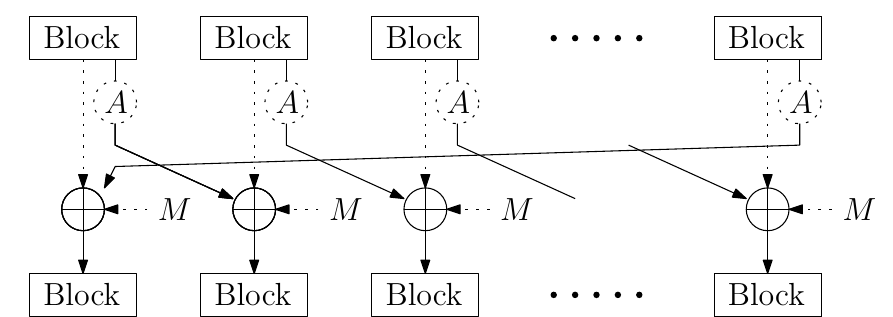
Figure 4: The general construction considered of the round function in [JN16]. Dash lines mean that it can be possible to be absent or present in the